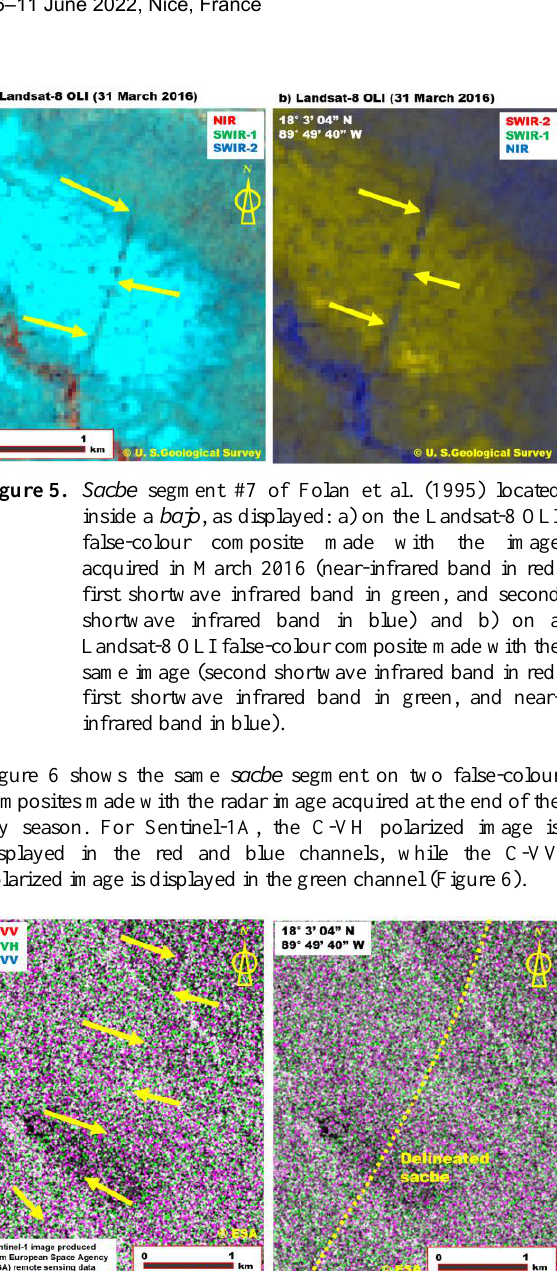
Figure 6. Sacbe segment #7 of Folan et al. (1995) found inside a bajo and surrounding forest area, as displayed on two false-colour composites made with the radar image acquired at the end of the dry season, with the Sentinel-1 image (C-VH band in red and blue, C-VV band in green). For the Alos-1 PalSAR imagery, in Figure 7, the L-HV polarized image is displayed in the red and blue channels, while the L-HH polarized image is displayed in the green channel. By contrast to the optical composites, the sacbe section crossing the bajo is less visible on the radar composites because the radar beam is too penetrating for differentiating the vegetation cover of the bajo from the one over the sacbe as it directly reaches the ground. In the forested section, the segment of sacbe is more visible on the radar composites. This can be explained by the double-bounce scattering produced by the difference in the vegetation density and the difference between the treetop and the soil